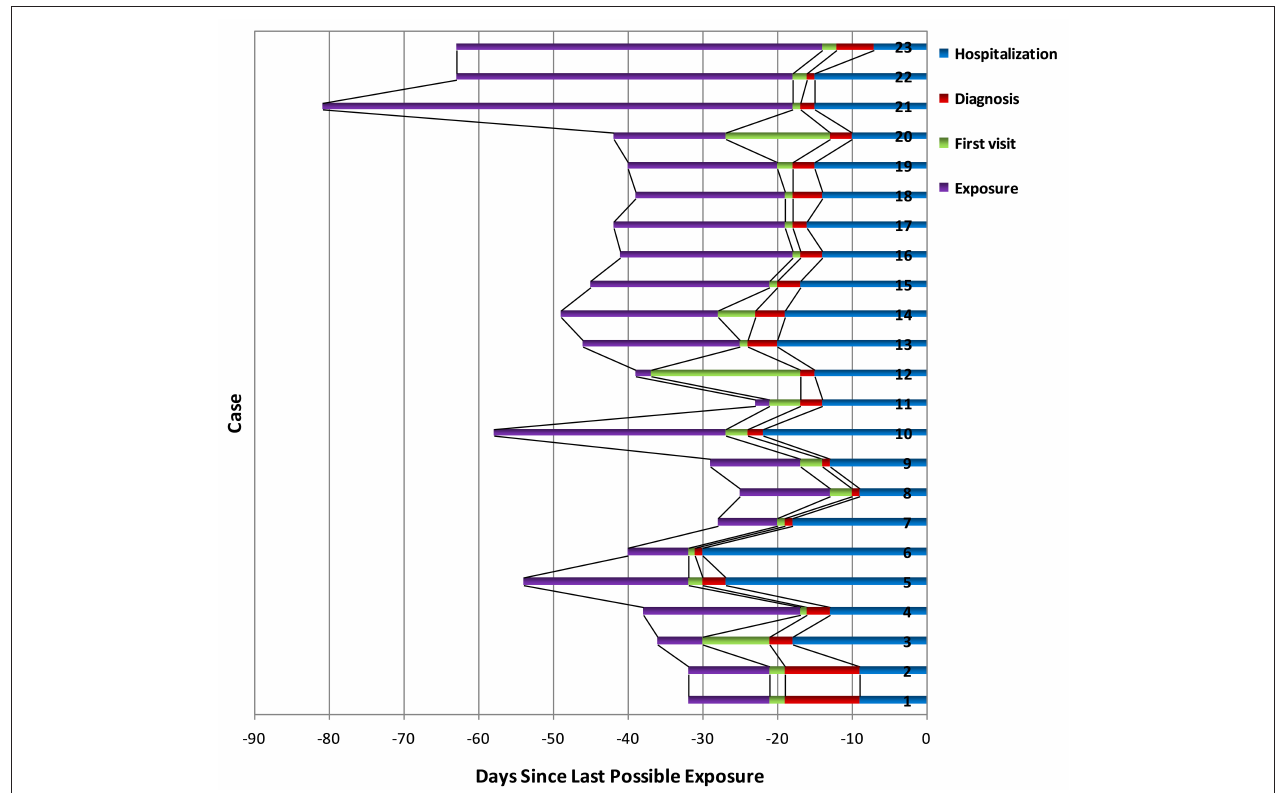
FIGURE 1 | SARS-CoV-2 exposure ( purple ), first visit ( green ), definite diagnosis ( red ), and hospitalization time ( blue ) for 23 confirmed cases. Bar regions represented the full possible time intervals for exposure, first visit, definite diagnosis, and hospitalization; serial number of cases was arranged according to the order of incidence.